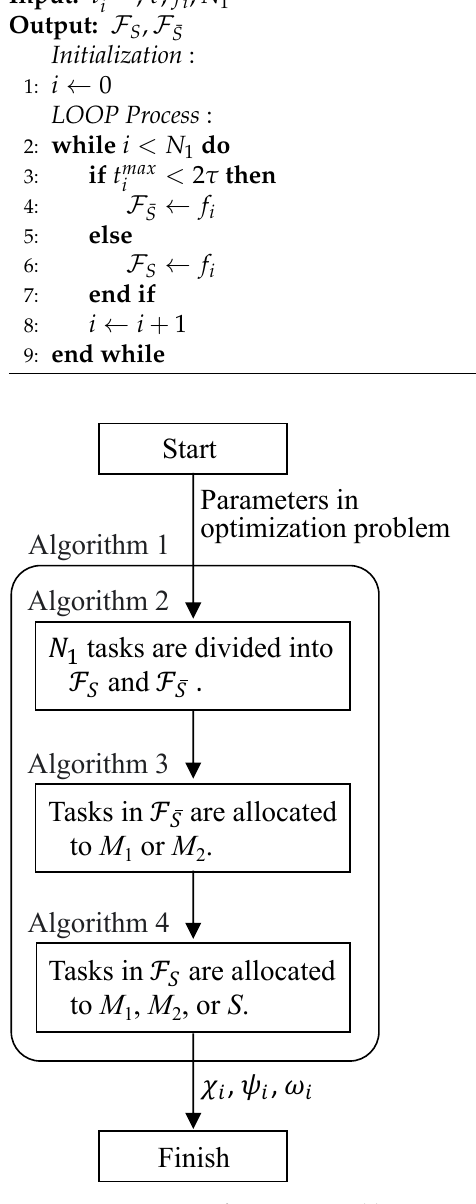
Figure 4. Overview of our proposed heuristic